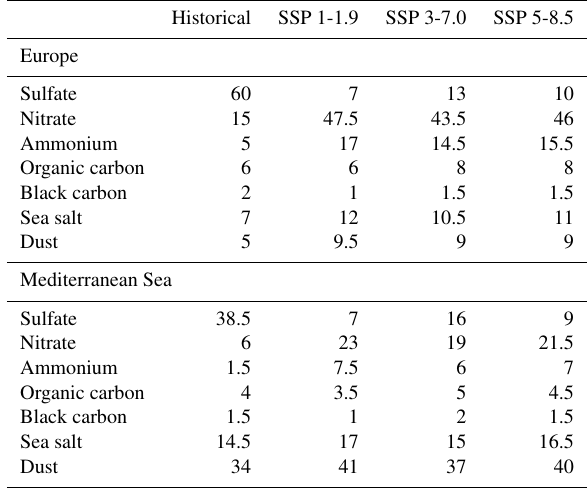
Table 2. Relative contribution (%) of the different aerosols to the total AOD (550 nm) over the historical period (1971–2000) and